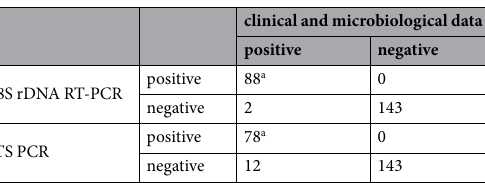
Table 1. Comparison of fungal identification by 18S rDNA RT-PCR and ITS PCR (N = 233) applying a gold standard that combines clinical and microbiologal data. a 76 clinical specimens were congruently tested positive by both